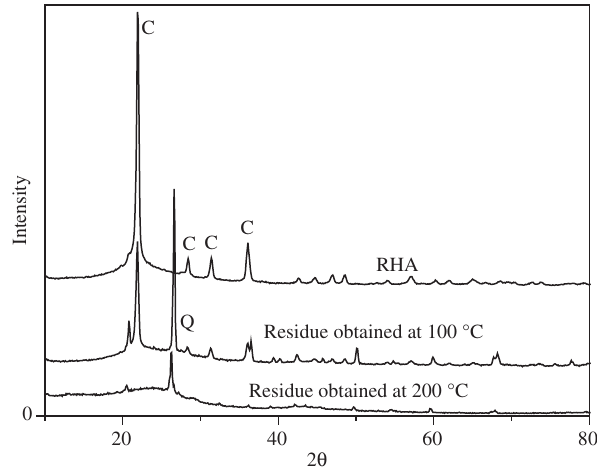
Figure 6. X rays diffraction of RHA and samples of residues attained in the filtration. (C = cristoballite; Q =